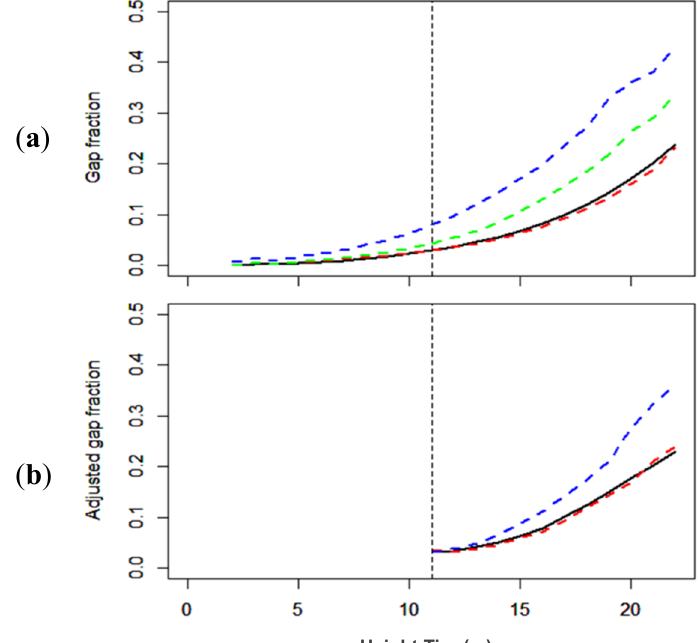
Figure 4. Gap fractions at different height above the forest floor, estimated from ( a ) airborne LiDAR and ( b ) permanently marked field plots. In the upper panel, curves from old-growth forest (solid black line), heavily logged forest (dashed blue and green lines) and less heavily logged forest (dashed red line) are shown (corresponding to blocks shown in Figure 5). In the lower panel, curves from unlogged sites (solid black line), well-managed logged sites (red) and poorly-managed logged sites (blue) are compared (minimum height = 11 m because only trees >10 cm DBH were recorded in the plots). We adjusted the estimates of gap fraction to account for overlap between individual tree crowns, by fitting them with the curve parameters extracted from LiDAR derived gap fractions. Gap fraction estimates indicate that the well-managed logged areas recovered back to their state prior to logging in terms of gap